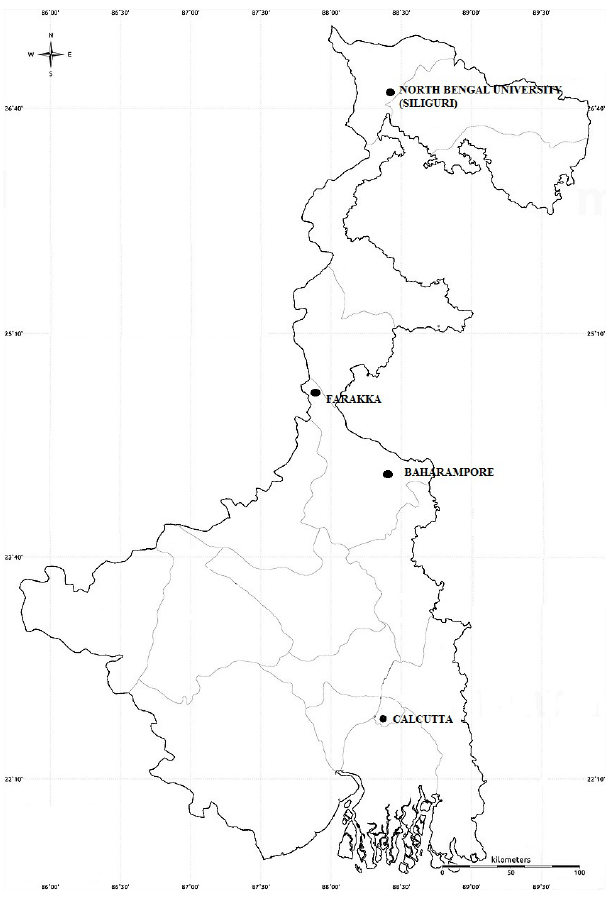
Fig. 1. Locations of dual-frequency GPS receivers in West Bengal, India, used for the